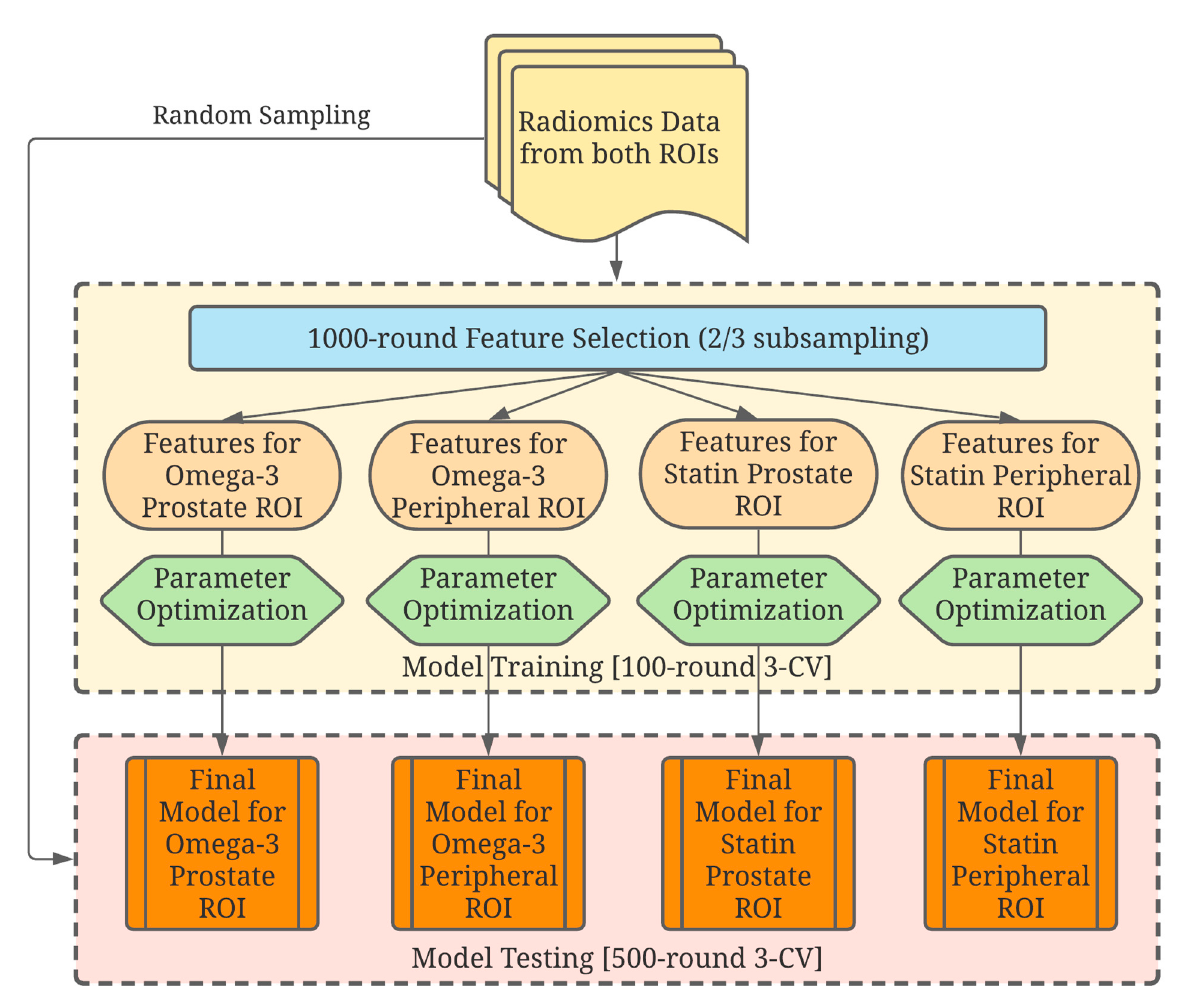
Figure 2. A schematic drawing of the data analysis workflow. Four independent combinations were analyzed, and their corresponding models were developed to study the effects of each drug on each region of interest (ROI).